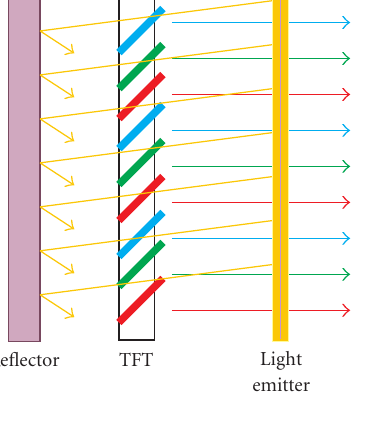
Figure 1: Reflective LCD.